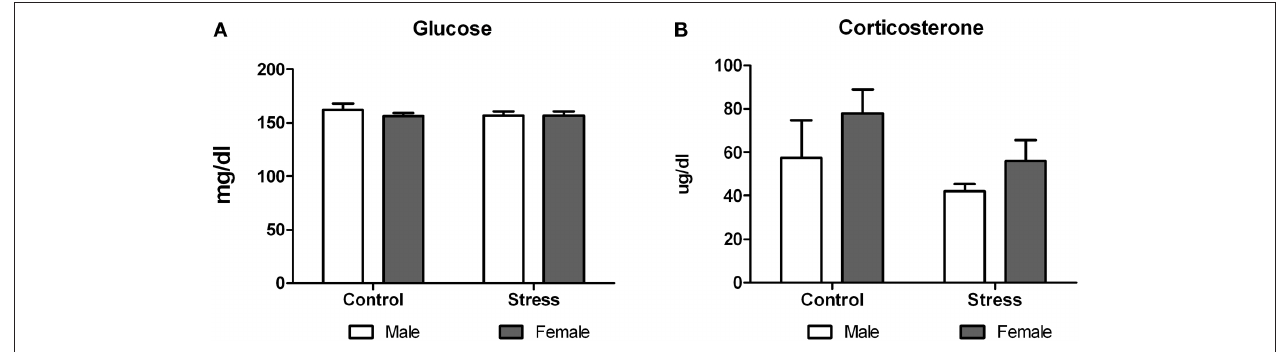
Figure 7 | effect of peri-pubertal stress on blood glucose and corticosterone. Mean (SEM) plasma corticosterone (a) and glucose (B) concentrations immediately after being at a novel location (acute stress) for male and female rats that underwent either peri-pubertal stress (Stress) or no stress